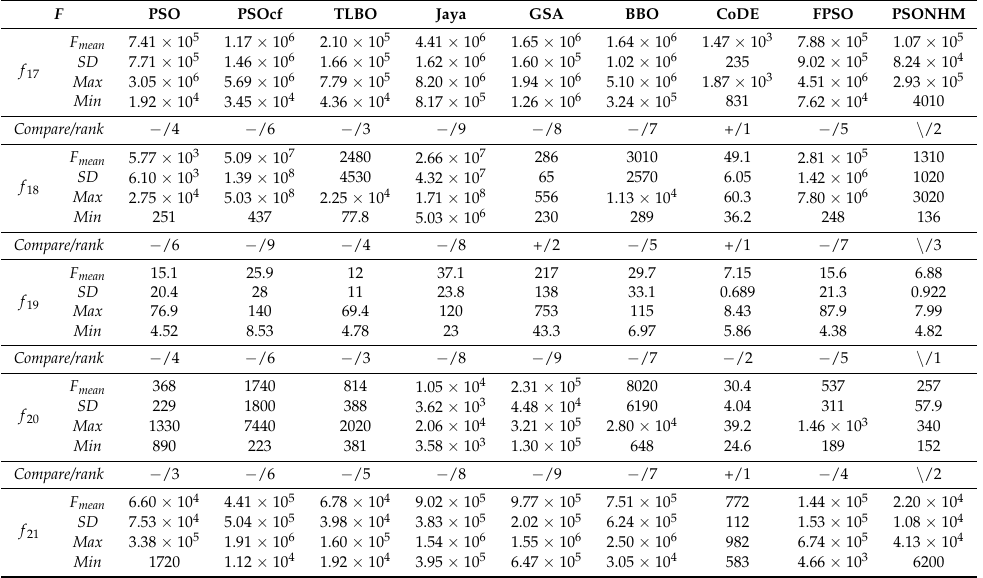
Table 4. Experimental results of PSO, PSOcf, TLBO, Jaya, GSA, BBO, CoDE, FPSO and PSONHM on f 17 – f 22